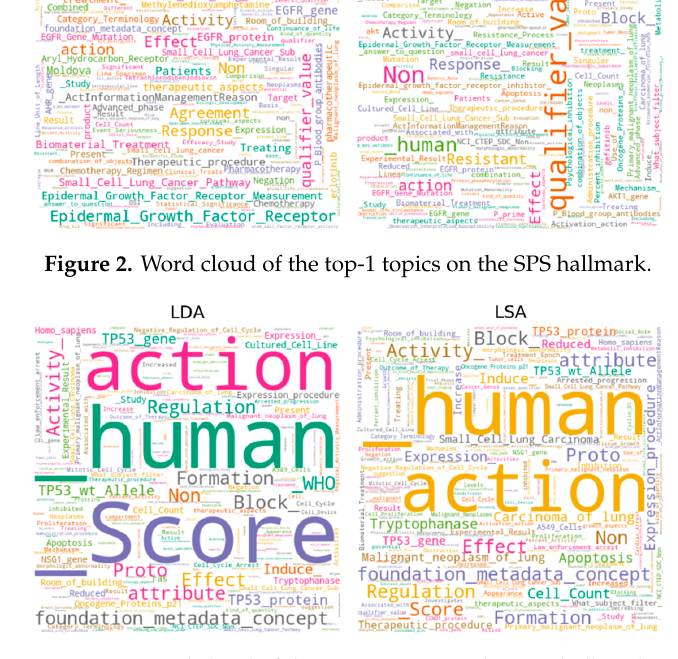
Figure 3. Word cloud of the top-1 topics on the EGS hallmark.